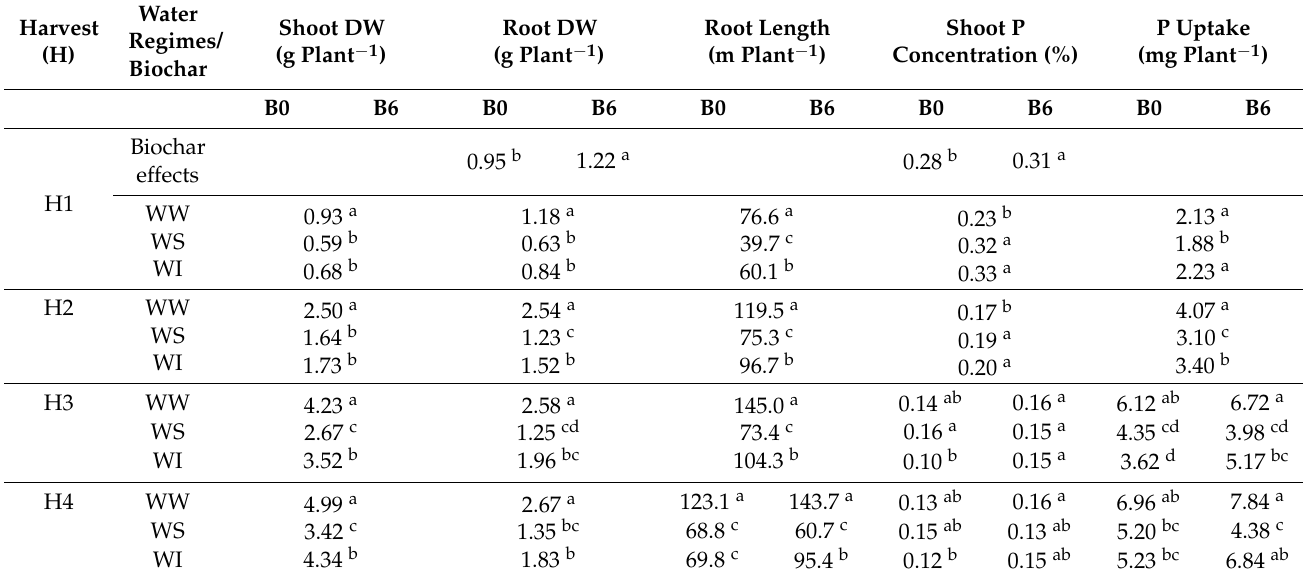
Table 2. Shoot and root dry weights, root length, shoot P concentration and P uptake per unit pot of wheat for the well-watered (WW), water-stressed (WS) and water intermittently (WI) treatments